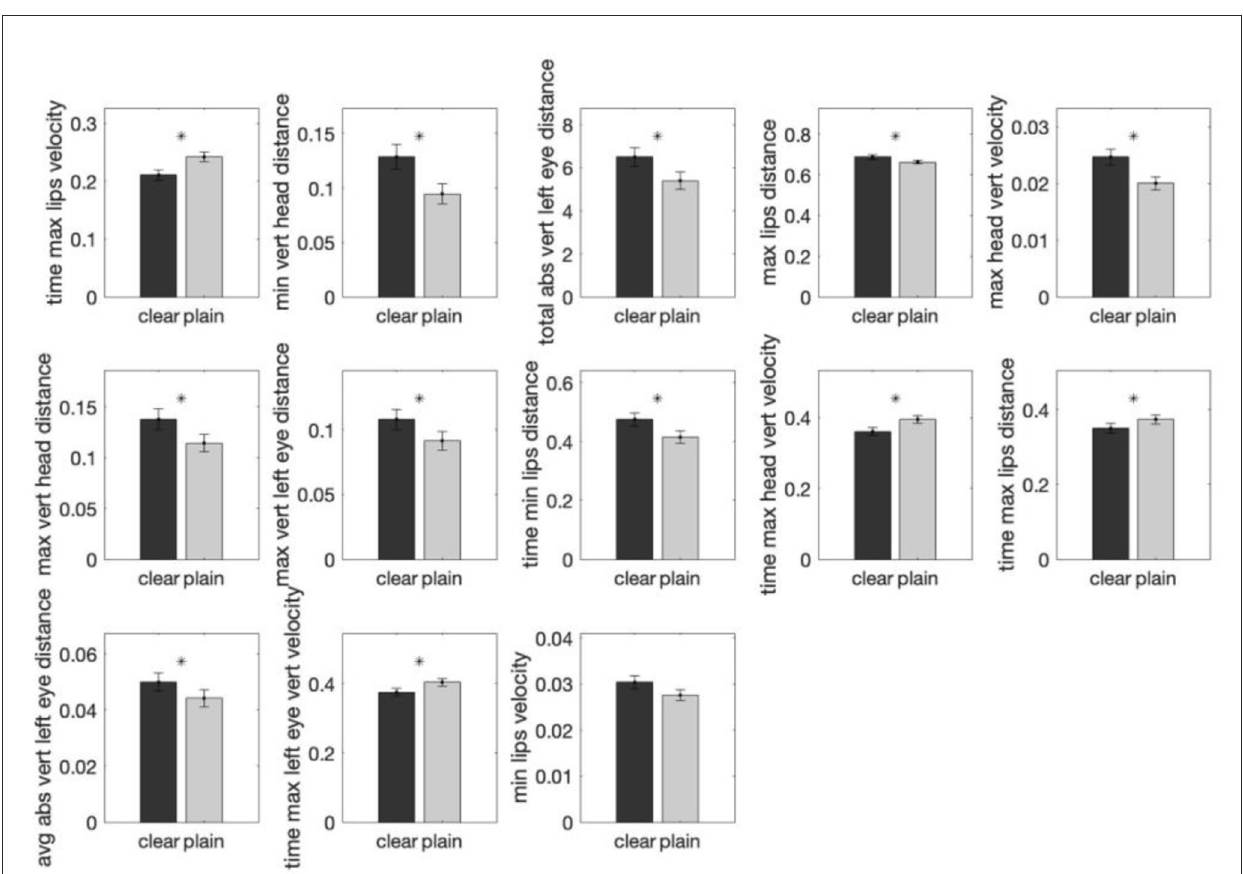
FIGURE3 Comparisons of the group means of each of the thirteen important features (determined by random forest analyses) in clear and plain style irrespective of the tones. The y-axis shows the average normalized feature value for that particular style group. Twelve features were found to exhibit statistically significant differences between the two speech styles by mixed-effects modeling. The error bar on each of the bar plots shows the standard error. A * above a bar represents a p-value smaller than